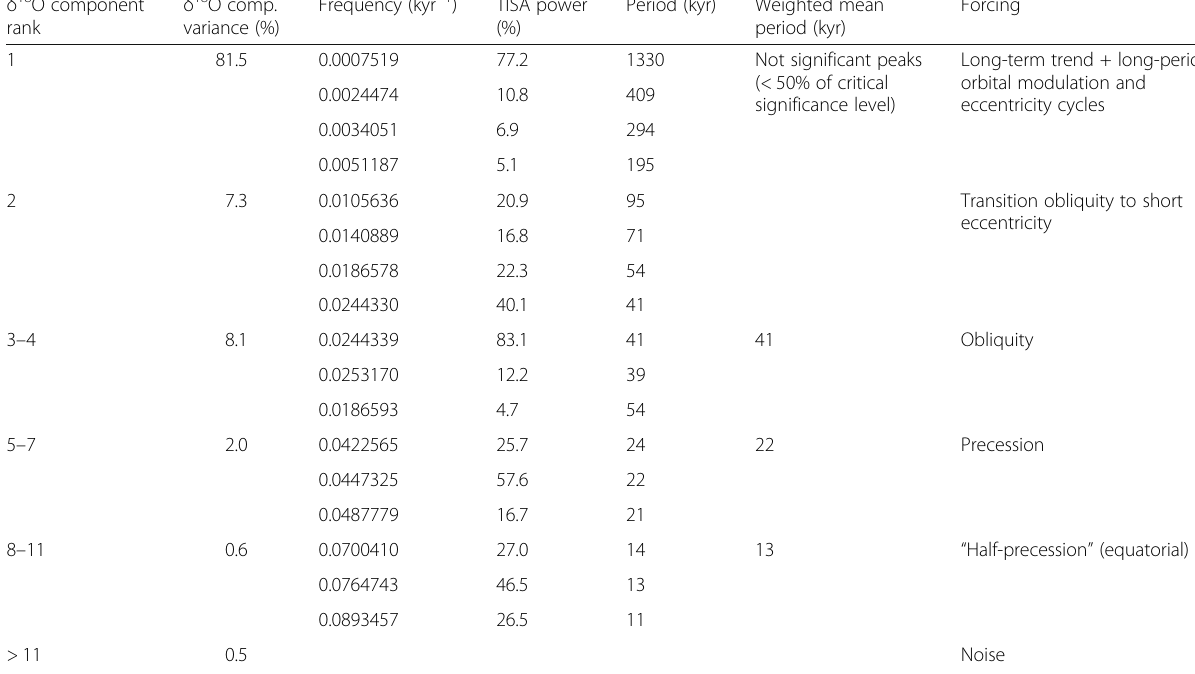
Table 1 Main descriptive parameters and Fourier frequency results of the five δ 18 O components isolated from the LR04 signal by singular spectrum analysis. The spectral peaks of the trend component-1 are not significant (< 50% of critical significance level) and are shown only for the purpose of discussion. Original LR04 data from Lisiecki and Raymo (2005b) are resampled at 1 kyr